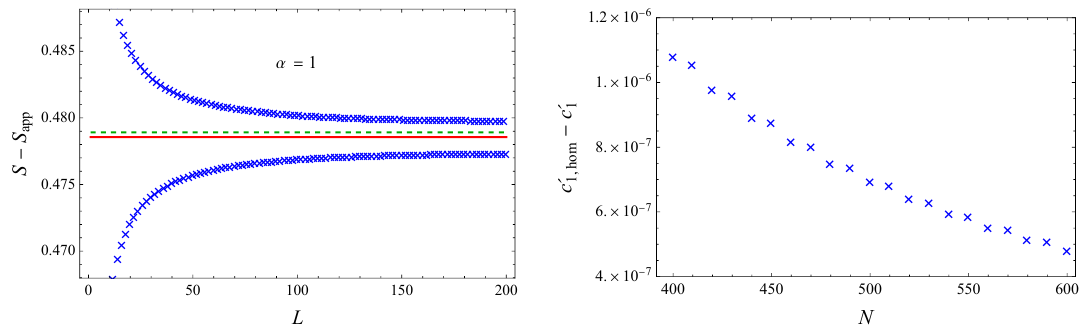
Figure 5 . Left: difference between the von Neumann entanglement entropy S of the Krawtchouk chain with q = 1 / 2 , N = 400 , k F = π/ 2 and its leading asymptotic approximation S app := (1 / 6) log f ( N, λ ) as a function of the block size L . (Only the range L = 1 , . . . , N/ 2 has been represented, since in this case S α is symmetric under L 7→ N − L .) The height of the red (resp. green dashed) horizontal line is the value of c 0 computed from eq. (7.8) (resp. as the average of the 1 differences S − S app for all block sizes). Right: difference c 0 − c 0 for N = 400 , . . . , 600 in 1 1 , hom increments of